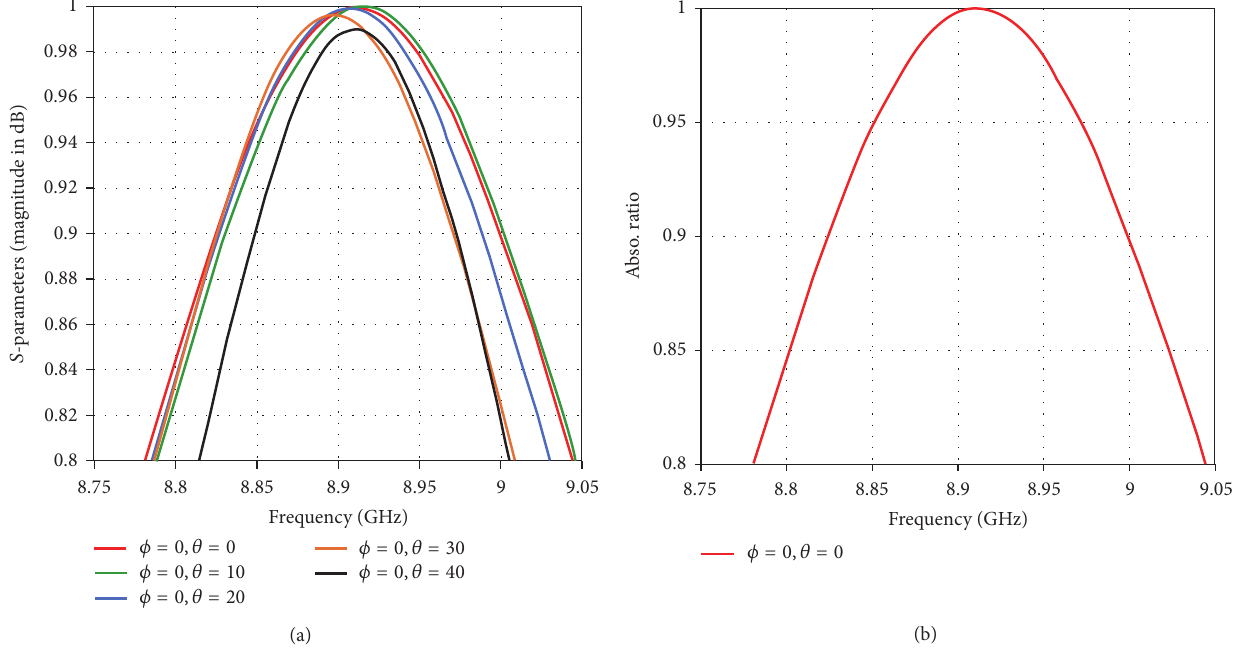
double negative permittivity and permeability in